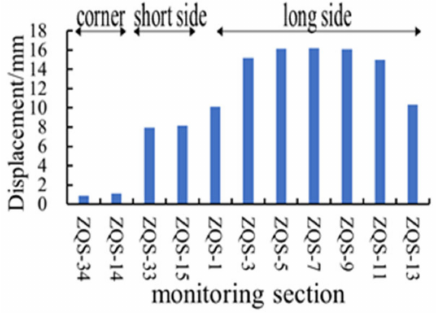
Figure 7. Horizontal displacement of piles top.